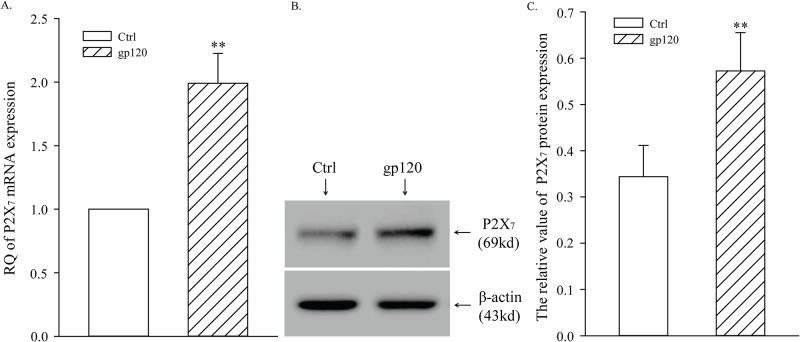
Gp120 up-regulated expression of P2X7 mRNA and receptor protein in primary cultured microglia.A, Relative expression of P2X7 mRNA detected by qPCR. B, SDS-PAGE electrophoresis of P2X7 receptor protein. C, Relative expression of P2X7 receptor protein; **P < 0.01, versus Ctrl group; n = 5.